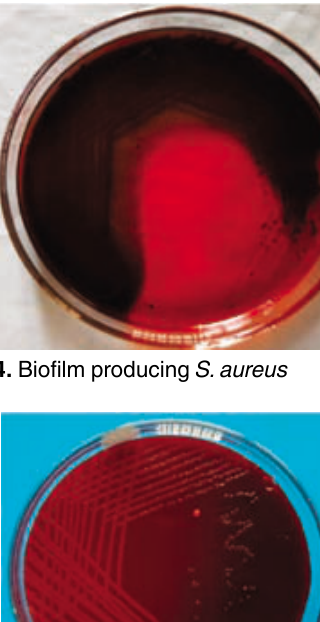
Fig. 3. Antibiogram of S. aureus (A)- antibiogram showing different combinations of nalidixic acid with berberine (B)- antibiogram showing different combinations of nalidixic acid with capsaicin. 1→ 8 g/L, 2→ 4 g/L, 3→ 2 g/L, and 4→ 1 g/L